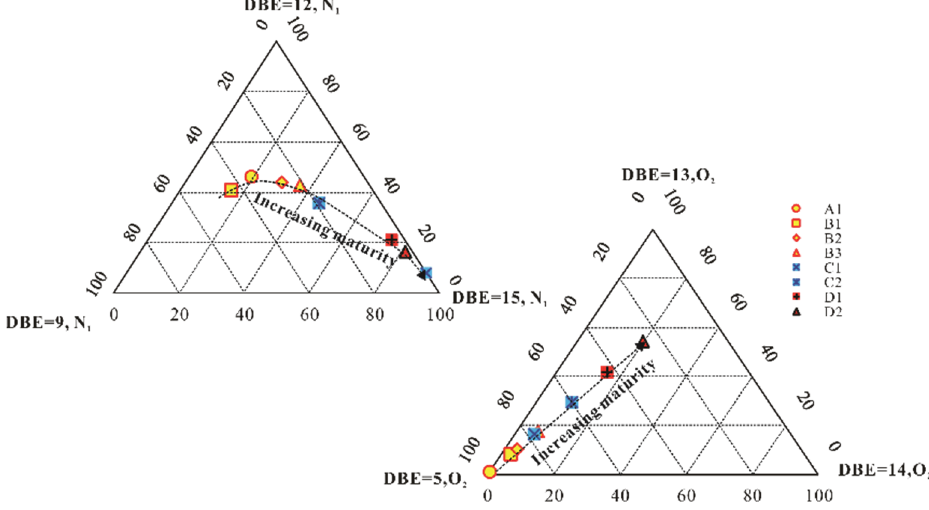
Figure 10. Ternary diagram of DBE = 9, 12, and 15 for N 1 and DBE = 5, 13, and 14 for O 2 . The ratios of C 29 sterane isomerization parameter ratio (20S/(20S + 20R) and ββ /( ββ